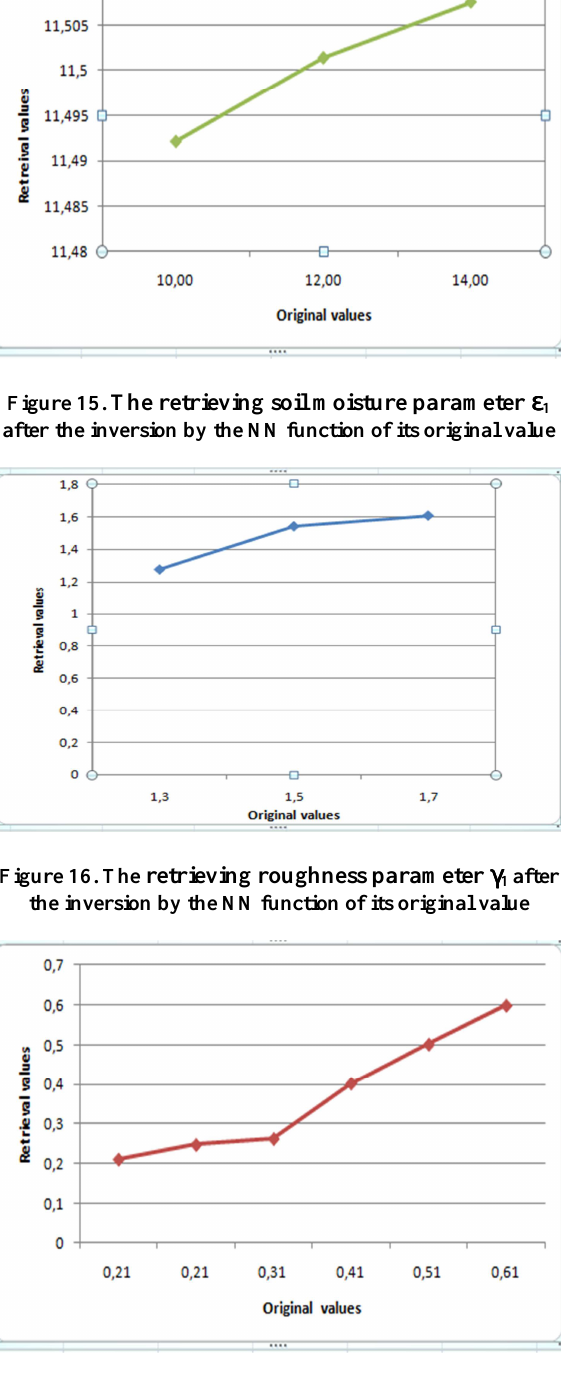
Figure 17. The retrieving roughness parameter nnnn 1 after the inversion by the NN function of its original